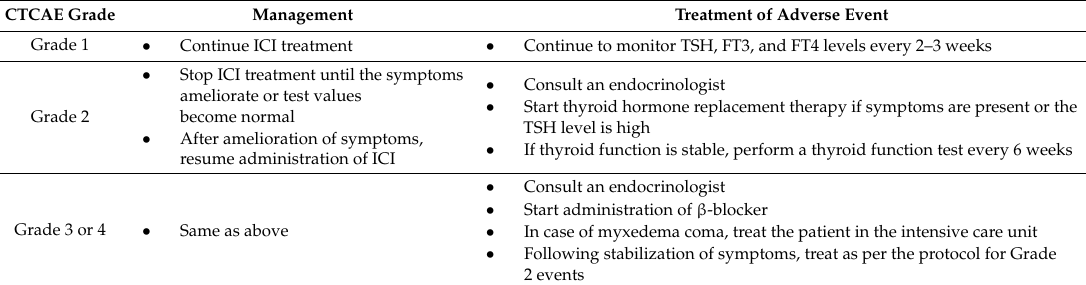
Table 5. Management of hypothyroidism induced by immune checkpoint